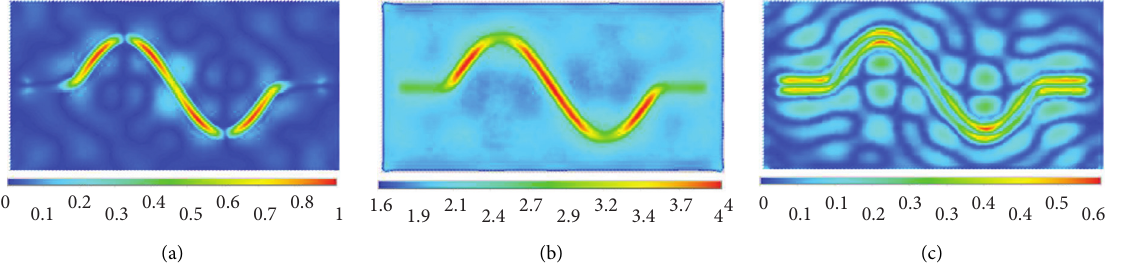
u u x , (b) y , and (c) z